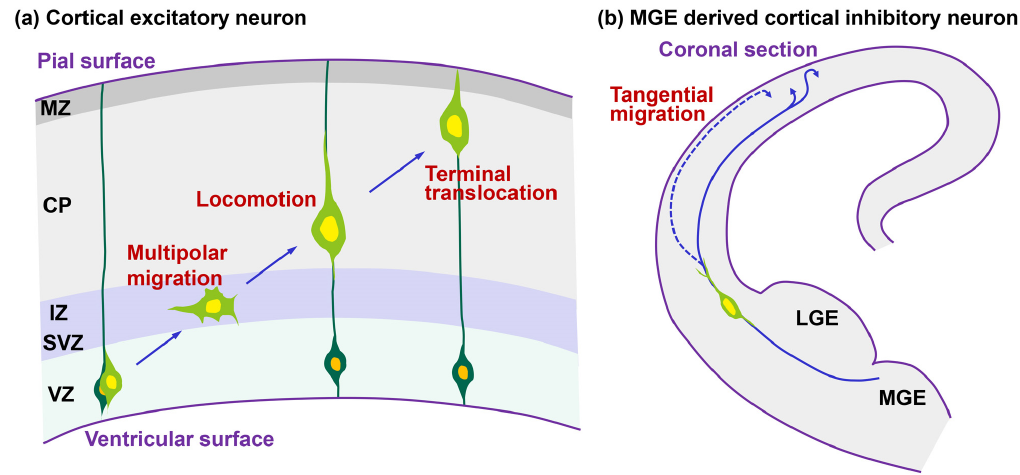
Figure 1. Migration mode and morphological changes of migrating neurons. ( a ) Cortical excitatory projection neurons (light green cells) are mainly generated in the ventricular zone (VZ) and transform into multipolar cells in the lower part of intermediate zone (IZ) or the subventricular zone (SVZ). Subsequently, these neurons transform into locomoting cells with a leading process in the upper part of the IZ. Locomoting cells migrate along the radial fibers of their progenitors (dark green cells) in the cortical plate (CP), and at the final term of locomotion, they contact the pial surface with the tip of the leading processes and translocate their nuclei (terminal translocation mode); ( b ) Cortical inhibitory interneurons are mainly born in the medial ganglionic eminence (MGE) and migrate tangentially through the cortex. There are three migration routes of cortical interneurons: (1) neurons migrate from the SVZ to the marginal zone (MZ) and after exhibiting non-directional movement in the MZ, they migrate into the CP, (2) neurons migrate from the SVZ to the CP, and (3) neurons directly migrate from the MGE to the MZ and subsequently migrate into the CP. Although the third route might be rare in vivo, it is frequently observed in the slice culture. LGE: lateral ganglionic eminence.